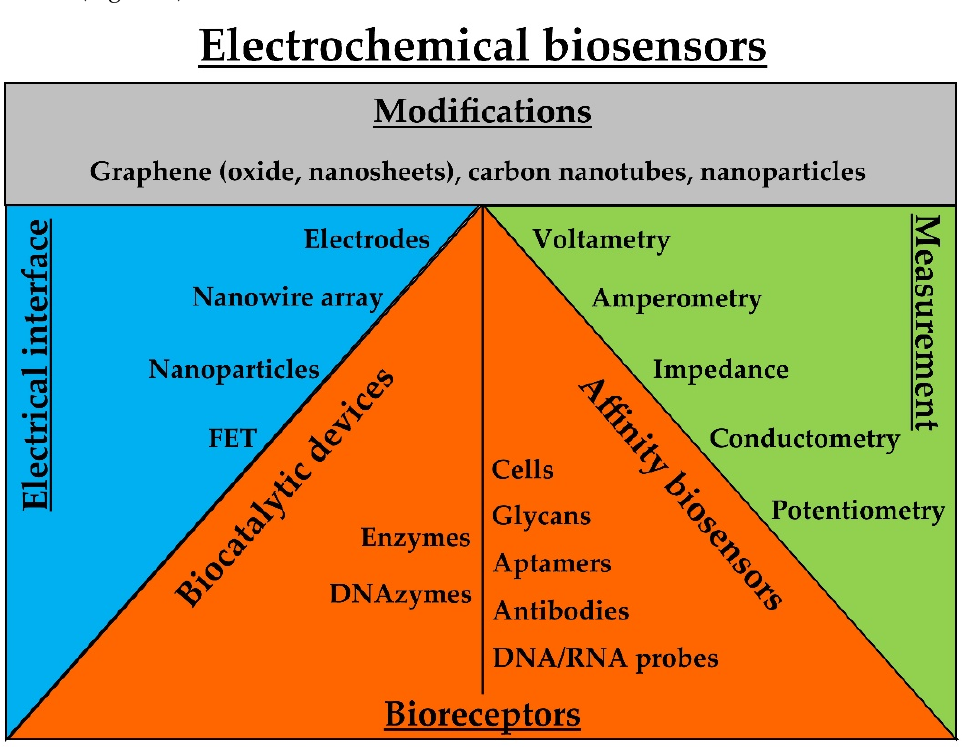
Figure 4. The basic components of electrochemical biosensors. The interaction of the targeted ana- lyte with the bioreceptor causes an electrochemical change that can be transduced to measurable signals via the electrical interface. Nanomaterials and nanoparticles are used to improve the performance of the biosensors.